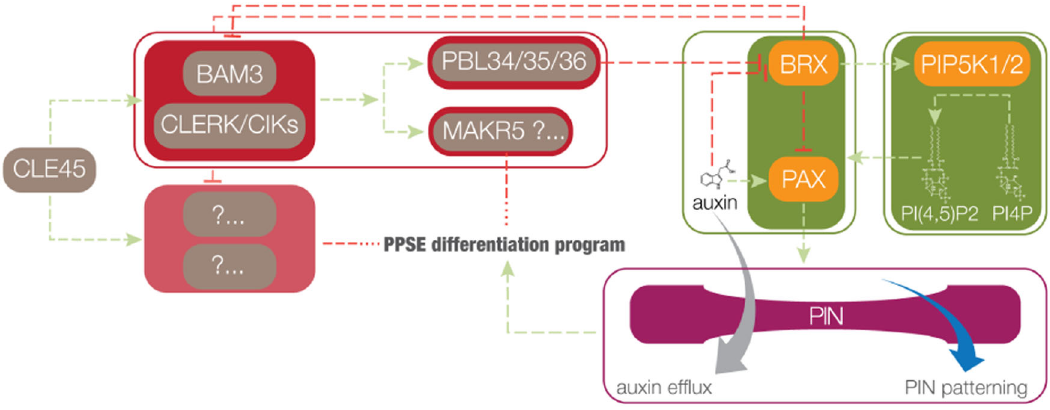
Fig. 6 | Schematic model of PAX polarity control. Schematic illustration of the central role of PAX polarity and activity for the integration of protophloem sieve element differentiation and root growth (not presenting spatial aspects; boxed in components represent modules rather than cellular compartments). Auxin ef fl ux control by the BRX-PAX rheostat is reinforced through mutual interactions with